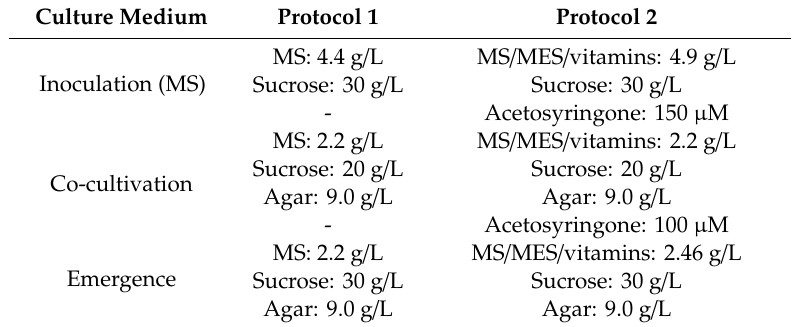
Table 1. Culture media composition employed for A. rhizogenes -mediated hairy root induction in lentil.